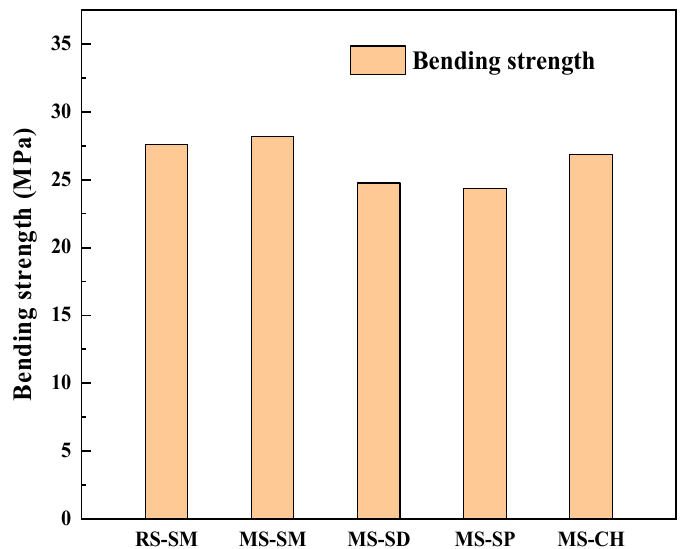
Figure 6. Bending strength of manufactured sand UHPC under different curing methods.